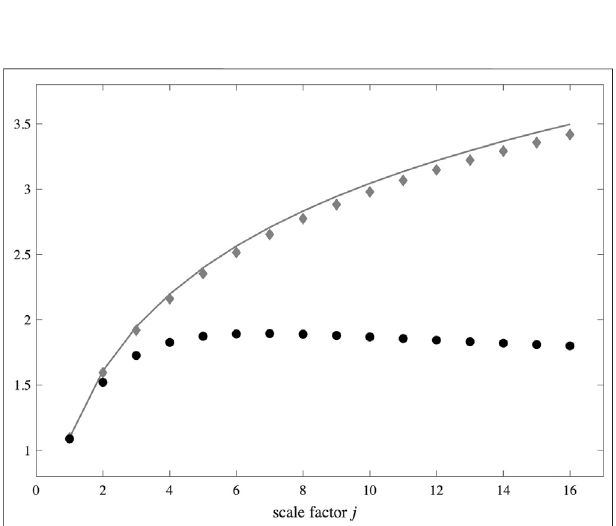
FIGURE 4 | The entanglement entropy of a boundary node with respect to the rest of the graph. Gray continuous line shows the maximum entropy attainable as function of the scale factor parameter. Gray diamonds show the result of Bianchi et al. (2018). Black circles show our result for